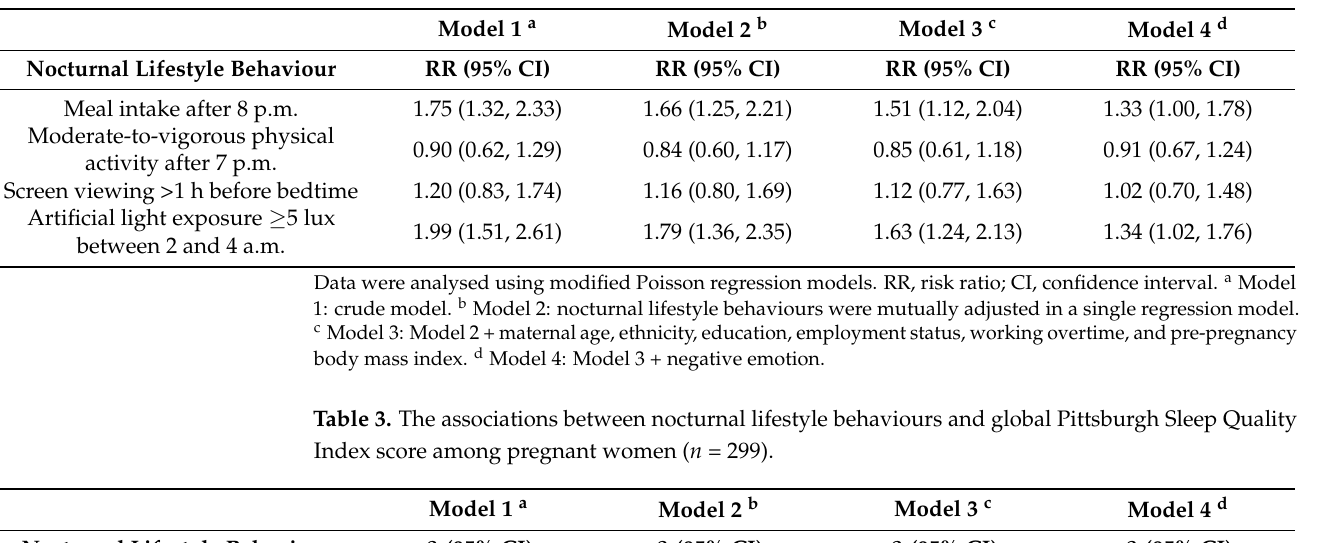
Figure 1. Bar chart illustrating the comparisons of women with good and poor sleep with respect to nocturnal behaviours (n = 299). * p < 0.001. Table 2. The associations between nocturnal lifestyle behaviours and poor sleep quality among pregnant women (n = 299).